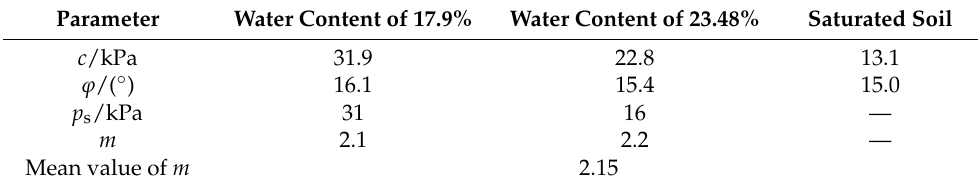
Table 1. The parameters of m .